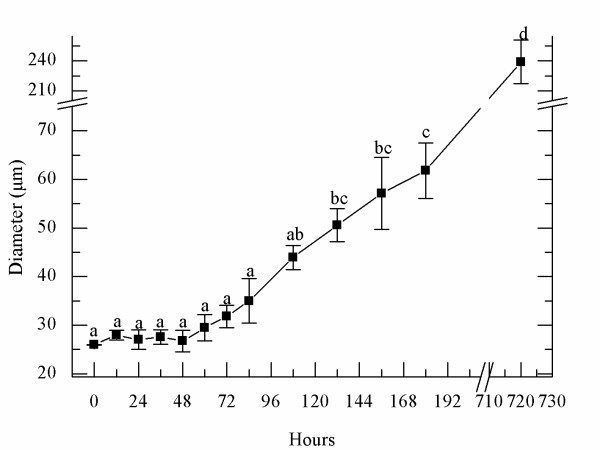
Variations in tetraspore/disk diameter during cruciate development. The time point at which the spores were freshly released was set as 0 hours. Statistical results suggest that there is no significant difference in diameter of spores or disks before 84 hours. After 84 hours, morphological changes occurred in marginal cells of the disk, the diameter began to increase (refer to Figure1-A-H). A one-way ANOVA and Students-Newman-Keuls Post Hoc comparison were used to test for statistical significance.